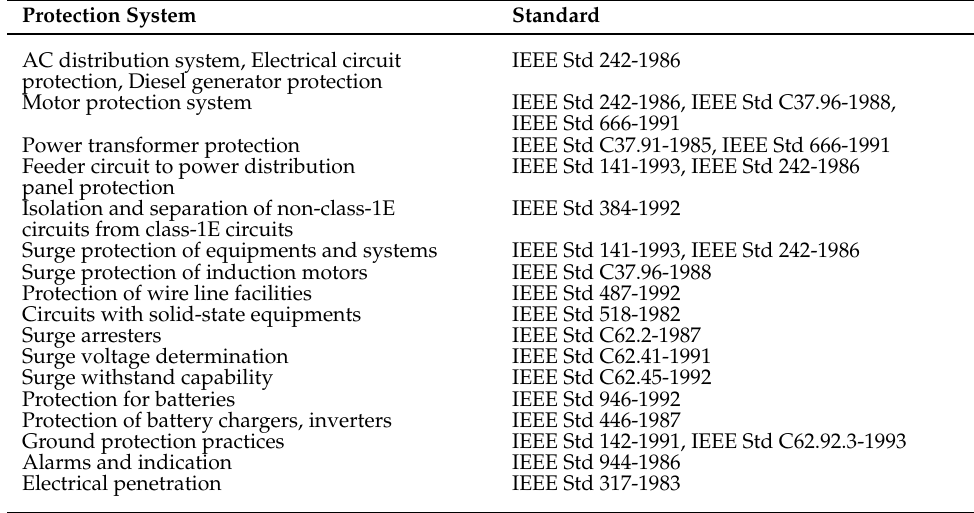
Table A1. Protection system and their